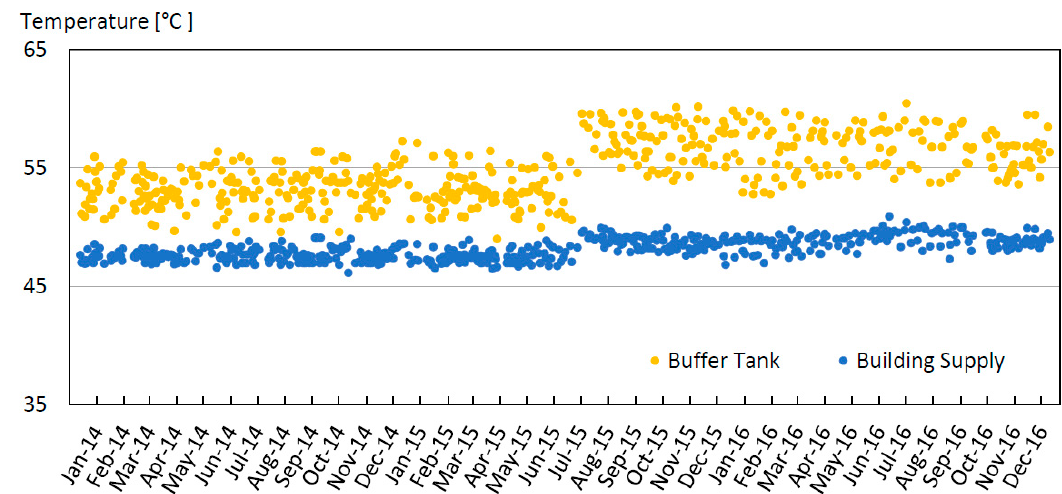
Figure 10. Measured daily average hot water temperatures drawn from the buffer tank and supplied to the building after anti-scalding tempering.